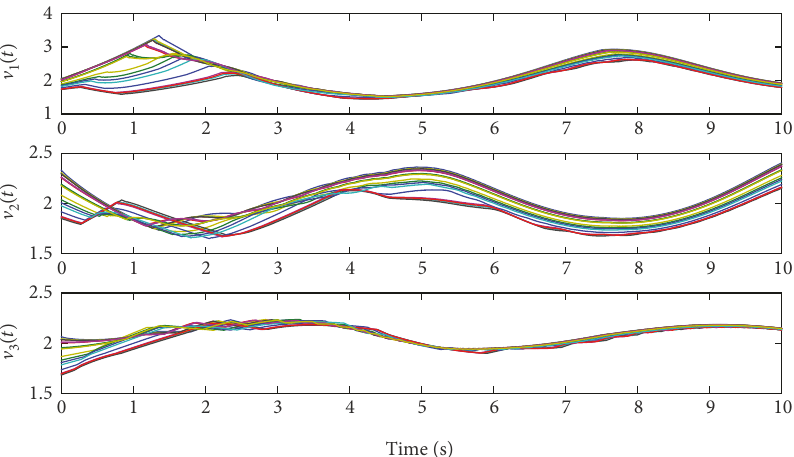
Figure 7: Control voltage signals commanded for the fi rst three SJA arrays (i.e., v